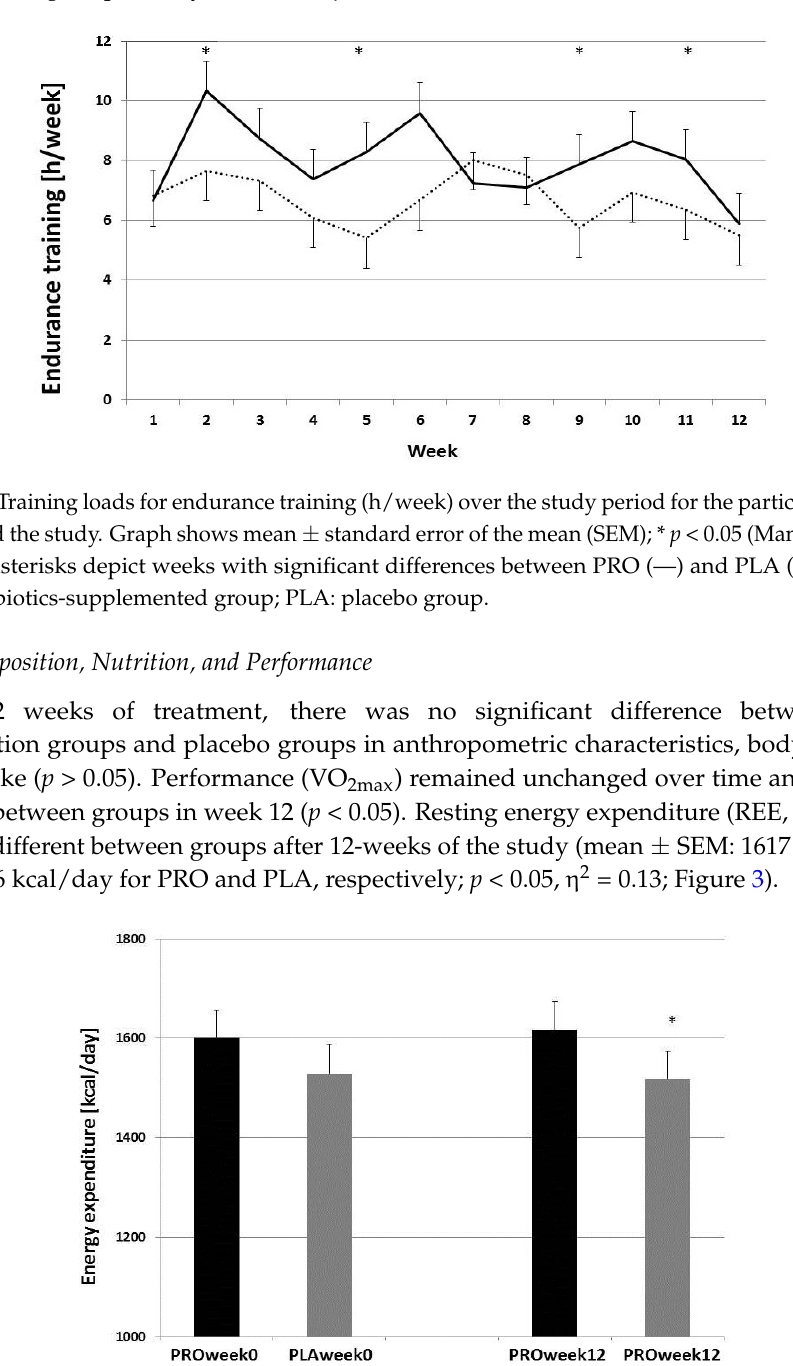
Figure 3. Resting energy expenditure (REE; (kcal/day)) in trained athletes before and after 12 weeks of treatment. PRO: probiotics-supplemented group ( n = 14); PLA: placebo group ( n = 15). Graph shows mean + SEM; * p < 0.05 (ANOVA).